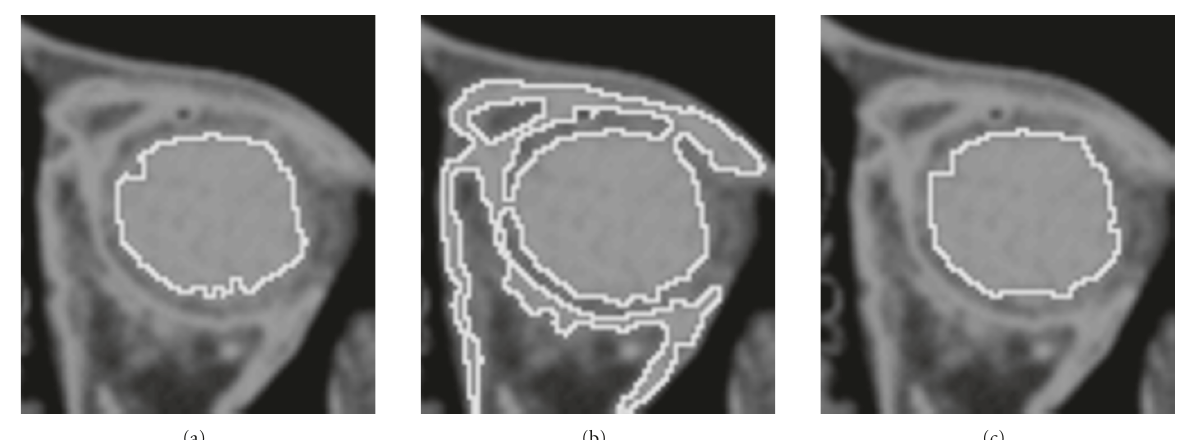
Figure 6: A CT image of the orbital region with one seed inside the eye ball. (a) A wavefront of cost κ which represents the maximum extent of this seed inside the eye ball. (b) The wavefront of cost κ +1 shows a considerable augment in size when it invades the background. (c) The pixel propagation order provides more continuous transitions of the wavefronts to select κ , interactively.